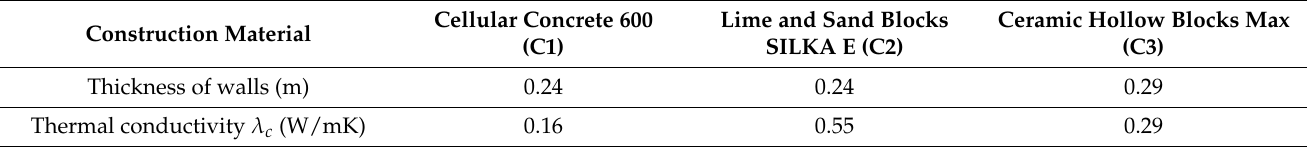
Table 2. Construction materials.